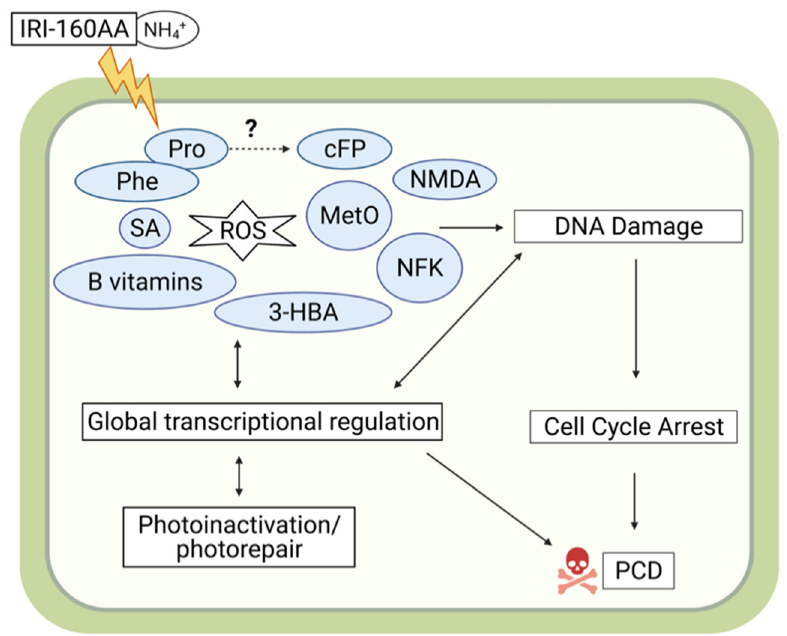
Figure 6. Schematic representation of a model depicting the cellular impact of IRI-160AA on Karlodinium veneficum revealed by this study and previously reported molecular and physiological data [25–27,30]. In this model, IRI-160AA stimulated ROS production, inducing the formation of oxidative stress markers, methionine sulfoxide (MetO), and formylkynurenine ( N ′ -formylkynurenine; NFK) in the cell pellets of the algicide treatment of K. veneficum . Cellular antioxidants also increased in response to ROS, including salicylic acid (SA), 3-hydroxybenzoic acid (3-HBA), proline, and B vitamins (riboflavin, thiamine, pyridoxal, nicotinic acid, and nicotinamide). Other compounds in- dicative of reactive oxygen species (ROS), DNA damage, and programmed cell death (PCD) that increased in the cell pellets included N -methyl- D -aspartic acid (NMDA), phenylalanine, and cy- clo(phenylalanine-proline) (cFP). cFP can enter the cells by simple diffusion, or by the biosynthesis from phenylalanine and proline, where the pathway has not been fully characterized (indicated by “?” in the figure). The figure was created with BioRender.com. Similar to MetO, formylkynurenine ( N ′ -formylkynurenine; NFK) is an oxidative stress biomarker and also an amino acid oxidation product [45–47]. NFK is a post-trans- lational modification of tryptophan that can be formed during the oxidation of its side- chain exposed to multiple ROS, including singlet oxygen, ozone, and hydroxyl radicals [45,46]. NFK has been identified as a biomarker for oxidative stress in plants exposed to high light, and may play a role in photosystem II (PSII damage and repair signaling [45,46]. Research has also suggested that NFK may serve as a protein antioxidant and pro- tect mitochondria from oxidative stress [47]. The selective increase of NFK in the cell pel- lets of K. veneficum is consistent with the observed ROS production stimulated by the al- gicide [25] (Figures 4 and 6). To be noted, NFK is also a photosensitizer; research has in- dicated its production may stimulate its further accumulation in the cells [47]. Here, the increase of NFK in the cell filtrate of both Rhodomonas and K. veneficum exposed to the algicide compared to the control implies NFK may also be (partially) provided by the